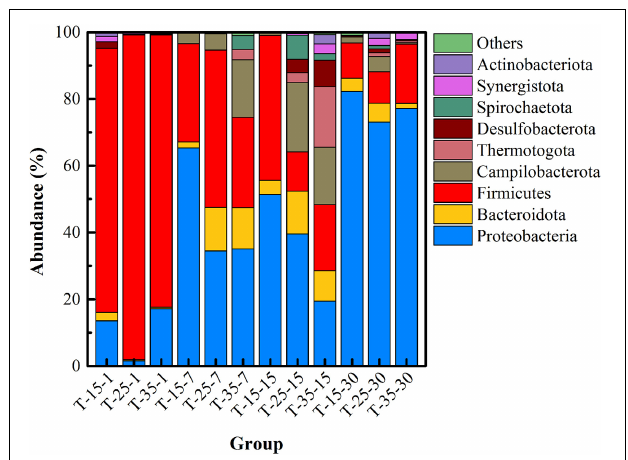
FIGURE 6 | Microbial community structure at the phylum level under different